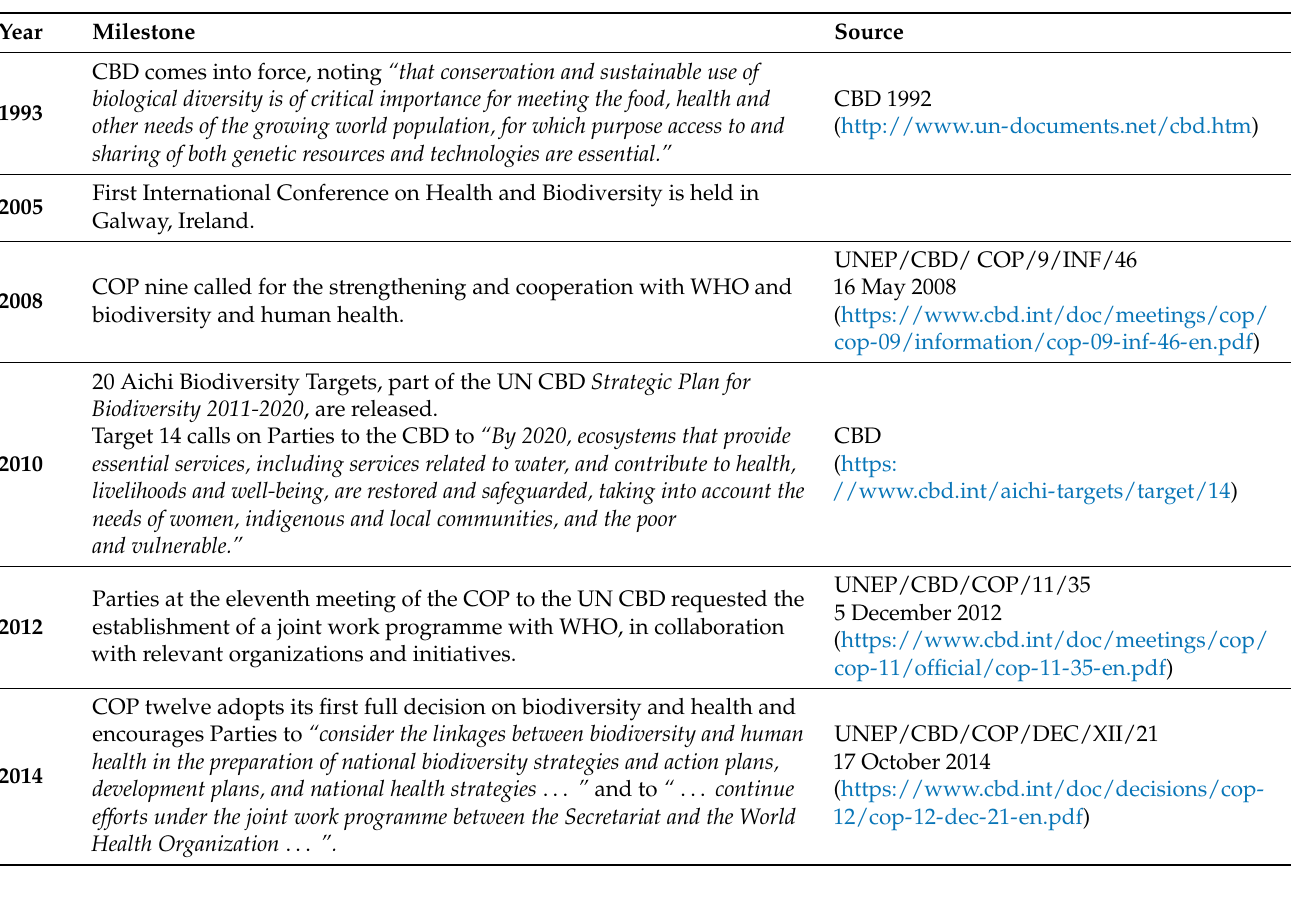
Table A1. Notable milestones recognizing biodiversity and human health by the Convention